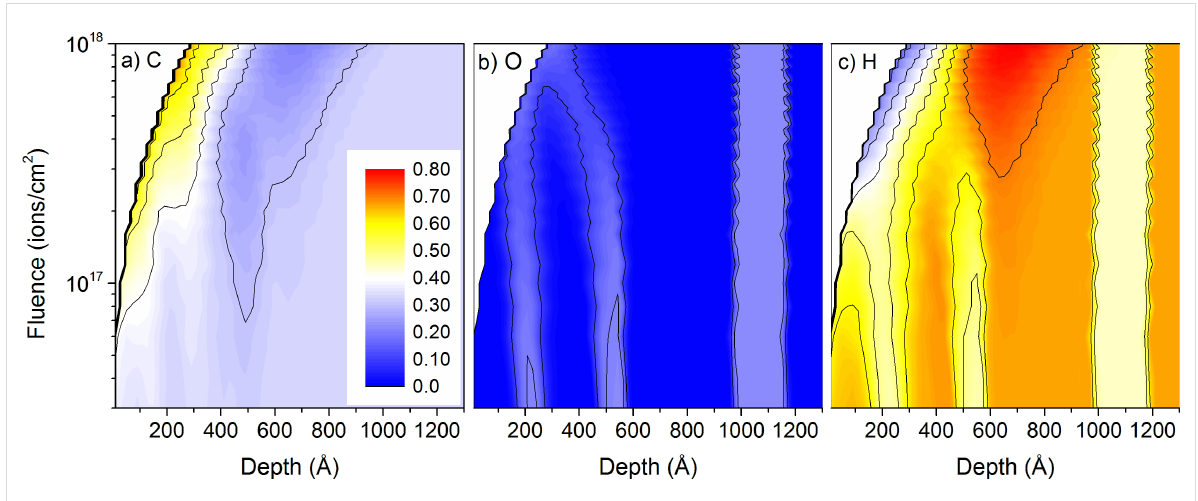
Figure 3: Sample composition as a function of depth and primary ion fluence for 1 keV He + irradiation of sample #6 with the thick-layer configuration: a) for carbon, b) for oxygen, and c) for hydrogen. The colour scale shows concentrations from 0 to 80% and is identical for all species.